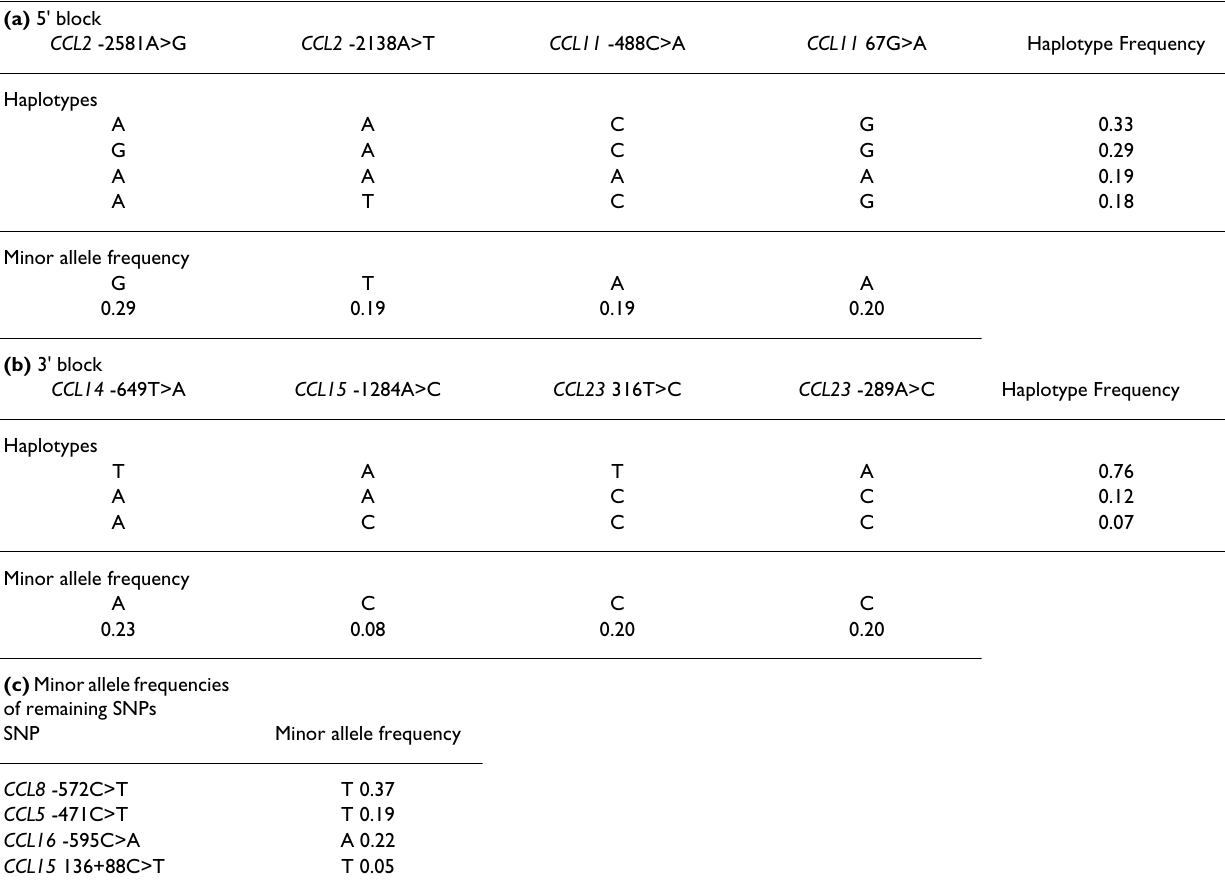
Table 2: Common haplotype and minor allele frequencies for SNPs within haplotype blocks in unaffected parents (n = 350–650 individuals), determined by individual